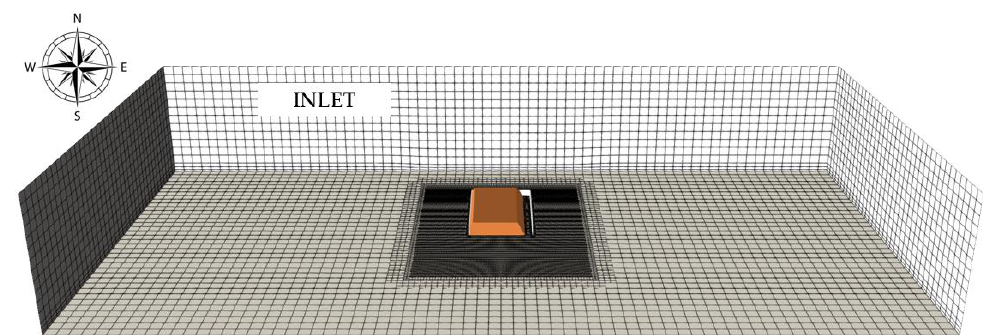
Figure 5. Computational domain and numerical grid. Example for HR configuration and wind coming from North.